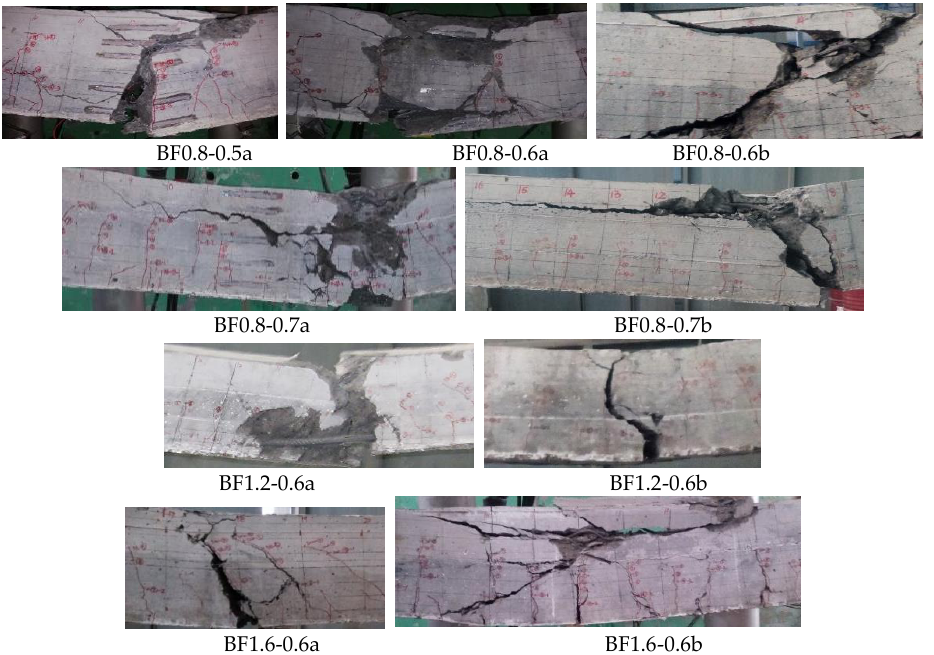
Figure 5. Interesting graphical locations of the fatigue failure patterns of test beams.